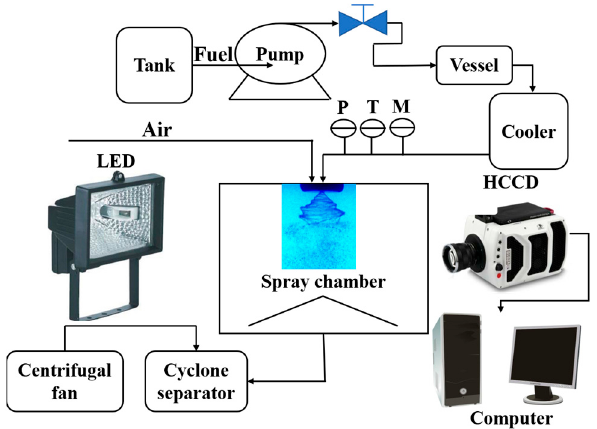
Figure 2. Schematic of the high-speed shadowgraph experiment system.